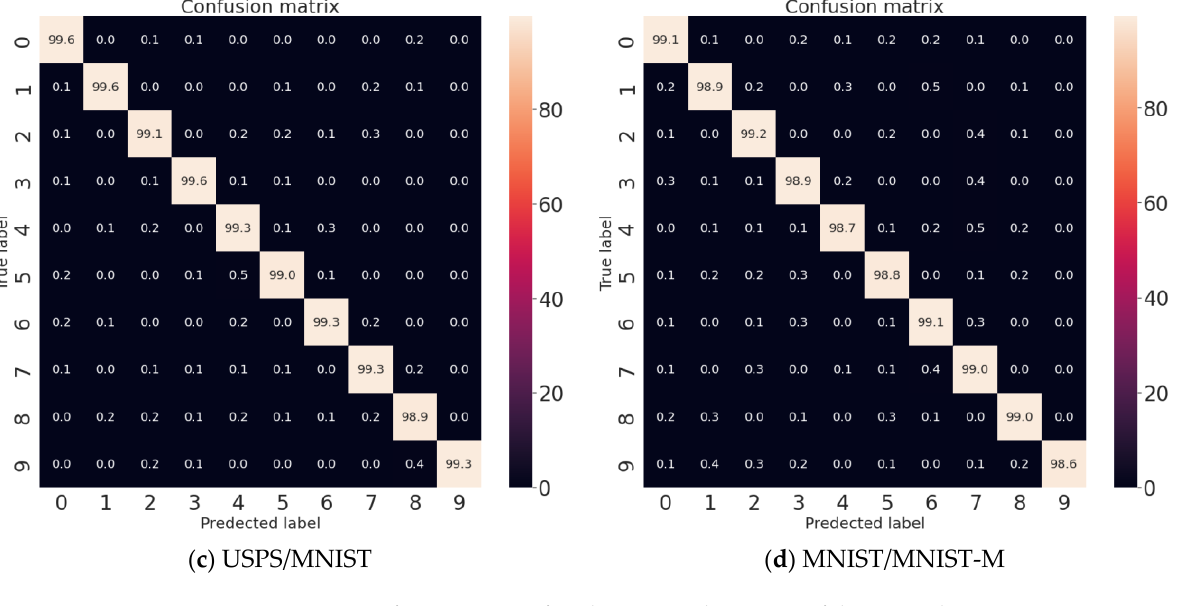
Figure 2. Confusion matrix of evaluation on the test set of the target dataset.